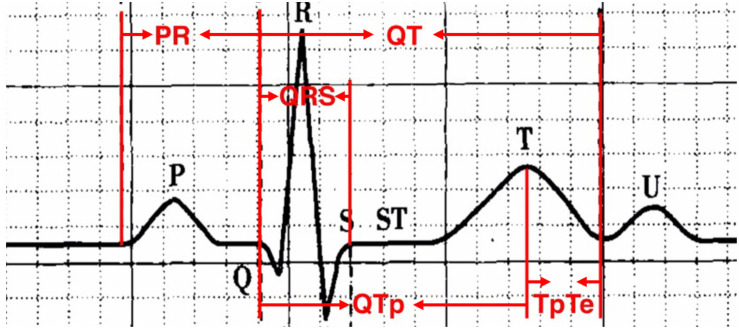
Definition of ECG parameters.